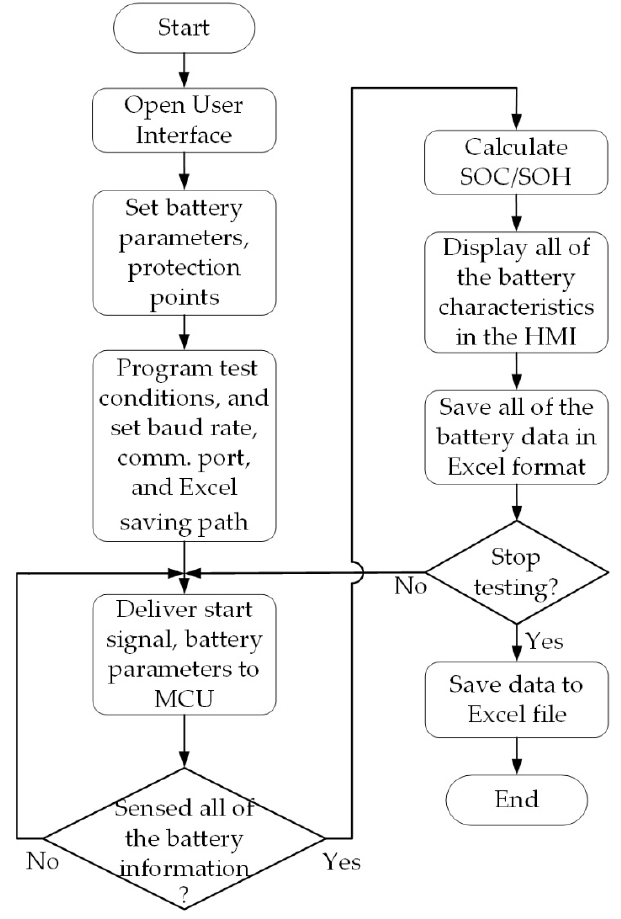
Figure 10. Flowchart of the proposed diagnostic procedure.